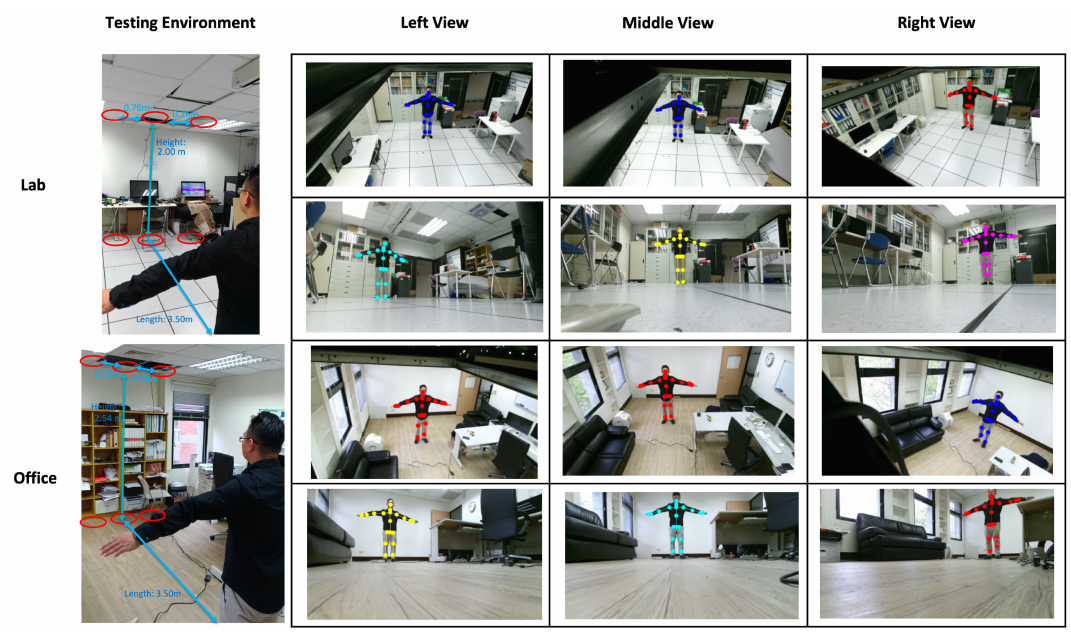
Figure 9. Skeletal joints obtained from Kinect SDK 2.0 [15] in “Lab” and “Office”